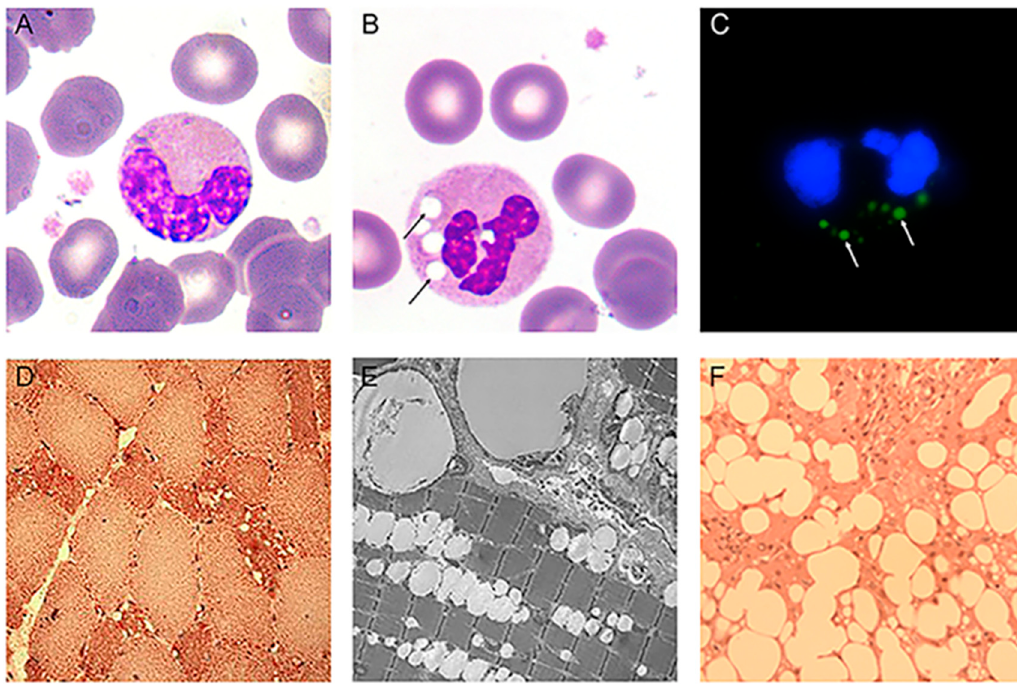
Figure 5. Evaluation of abnormal LDs in specific tissues. Microphotographs of Jordans’ anomaly, indicated by arrows, in NLSD patient buffy coats stained with May-Grunwald-Giemsa (MGG) ( B ) compared to control cells ( A ) (magnification 100 × ). ( C ) Immunofluorescent imagine of NLSD granulocytes stained with Bodipy493/503 (Jordans’ anomaly) and DAPI (nuclei) (magnification 100 × ). ( D ) Histochemical characterization of NLSDM quadriceps muscle biopsy, stained with Oil red O (ORO). Abnormal storage of neutral lipids is primarily detected in hypotrophic type I fibers. Image courtesy of Prof. Marina Mora (Fondazione IRCCS Istituto Neurologico “Carlo Besta”, Italy). ( E ) Electron microphotographs of human quadriceps muscle from a subject with NLSDM. Large LDs are located near to mitochondria and the subsarcolemmal region. Image courtesy of Prof. Marina Mora (Fondazione IRCCS Istituto Neurologico “Carlo Besta”, Italy). ( F ) Diffuse macrovesicular steatosis (ORO staining) in a liver biopsy from a subject with NLSDI. Image courtesy of Prof. Eugenia Valadares (Department of Propedêutica Complementar, Universidade Federal de Minas Gerais, Belo